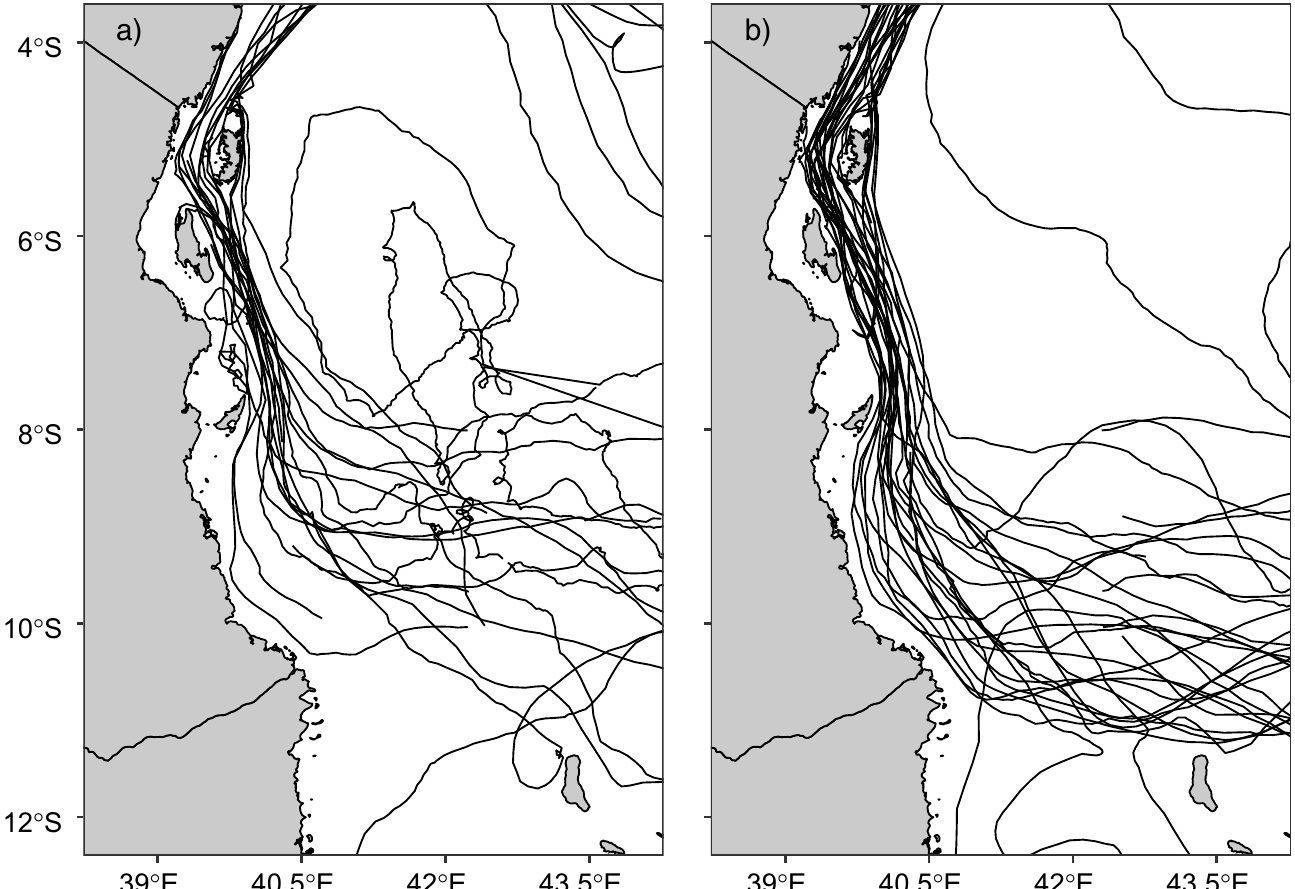
Fig 9. Trajectories of drifters that passed through the Pemba channel during a) the NE and b) SE monsoon season.